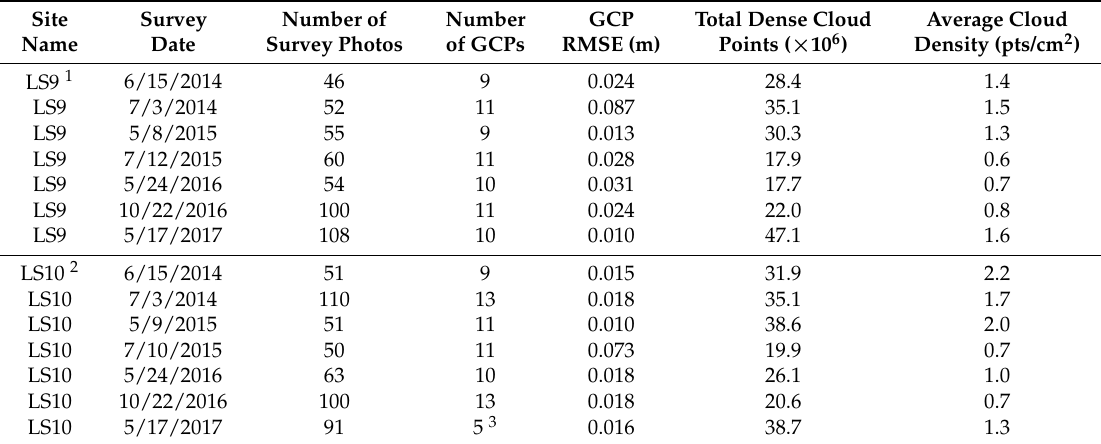
Table 1. Repeat Structure-from-Motion photo survey information. Abbreviations used for ground control points (GCPs) and root-mean-square error